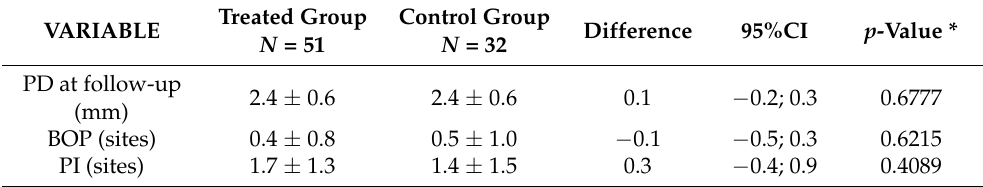
Table 3. Results at follow-up (T2).